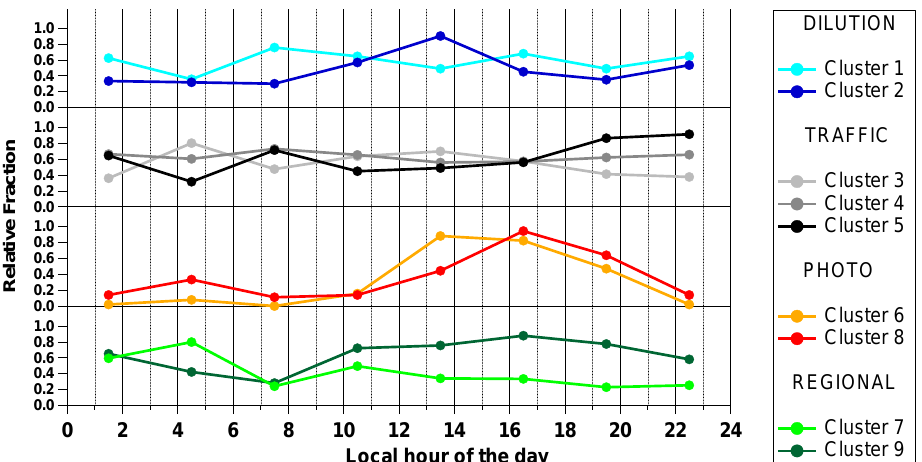
Fig. 5. Diurnal profiles for DMPS clusters. Cluster 3, 7 and 9 peaking during day or night time; cluster 1, 4 and 5 with a strong peak during the morning traffic hours and Cluster 2, 6 and 8 with a strong peak in the warmest part of the day